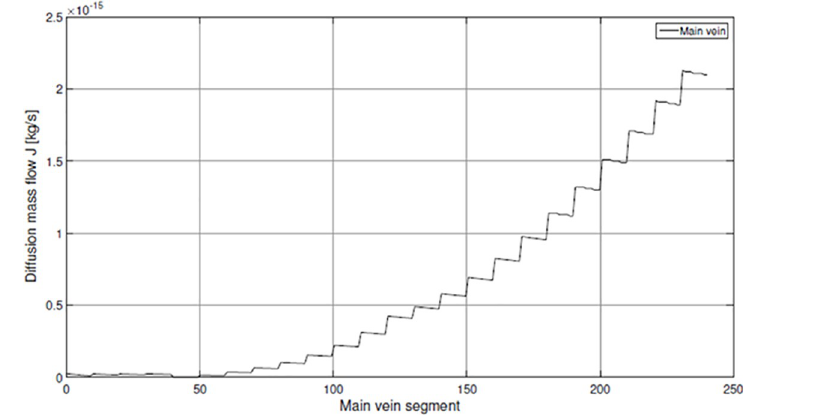
Fig 16. Diffusion mass flow along the main